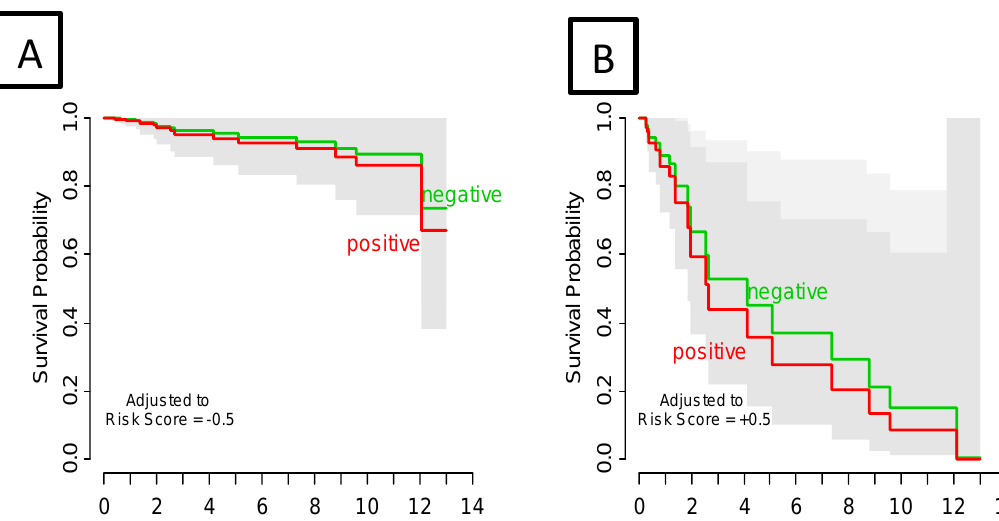
Adjusted to Risk Score = +0.5